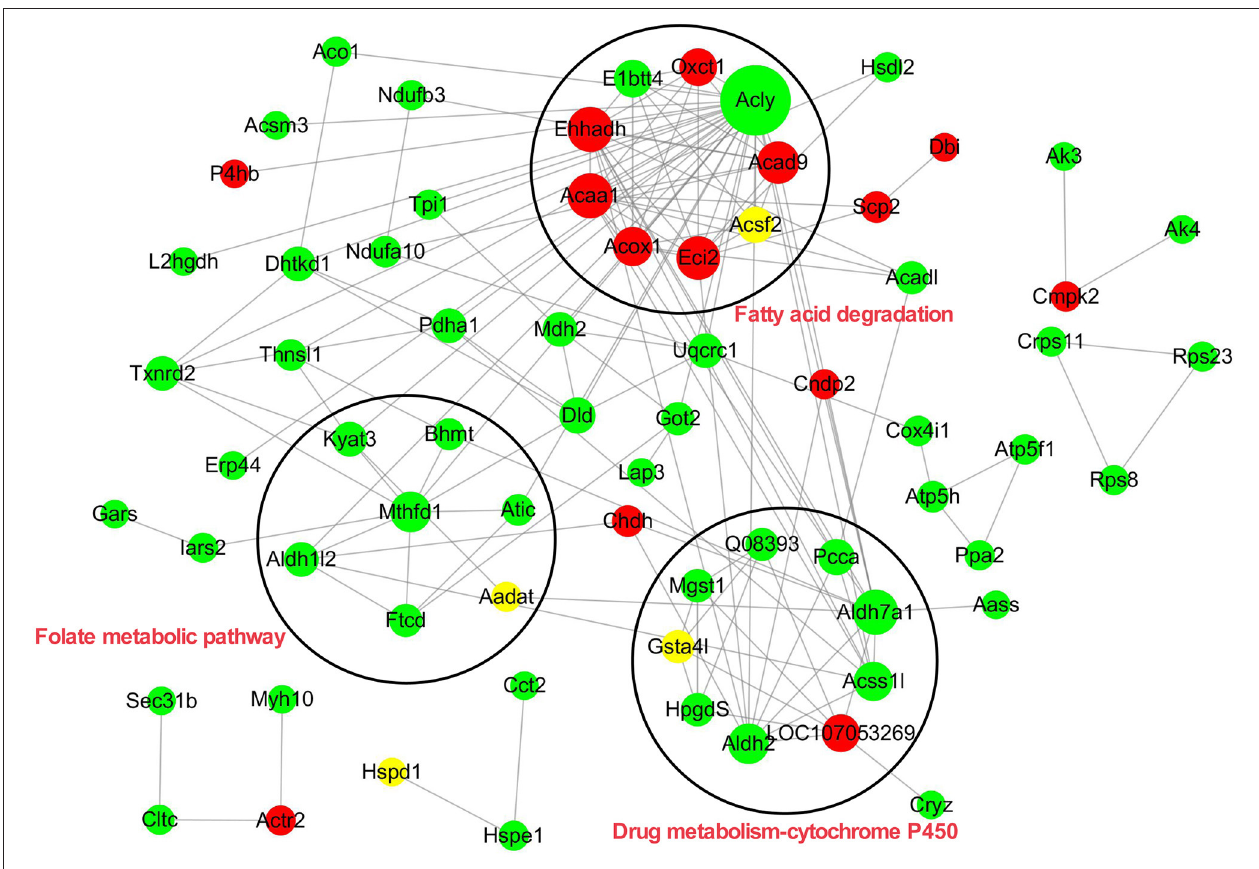
FIGURE 7 | Protein–protein interaction network of all differential kac